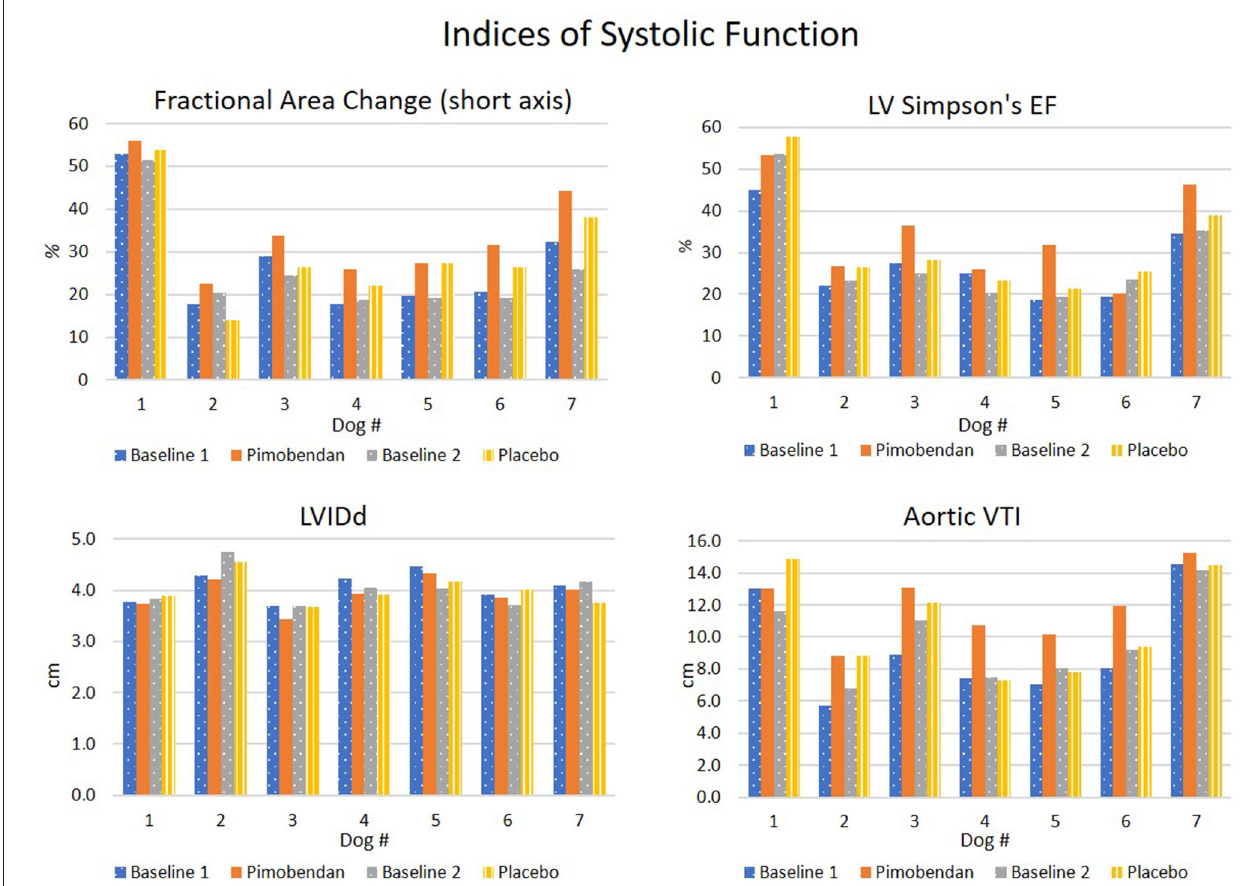
FIGURE 2 | Summary of systolic function indices. LV Simpson’s EF, LVIDd, left ventricular internal diameter in diastole from short axis M-mode; VTI, velocity time integral of aortic outflow.